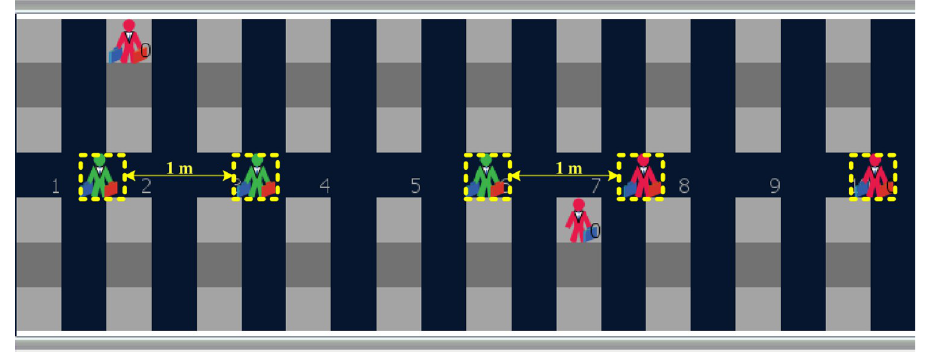
Fig 10. Example of turtle agents.